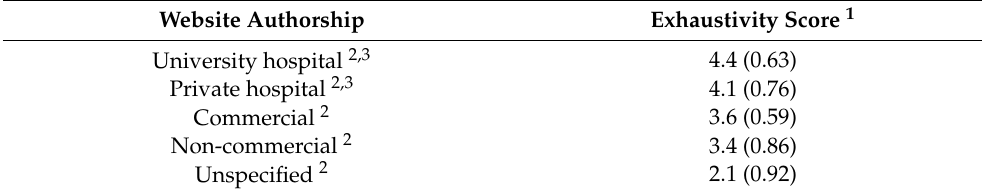
Table 7. Exhaustivity scores by website